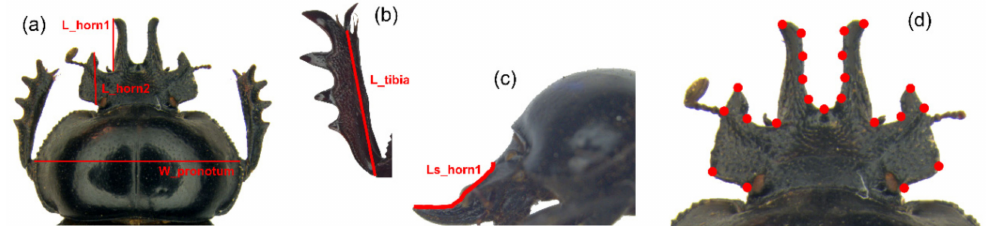
Figure 2. Linear measurements and landmark configuration. ( a ) Maximum pronotal width (W_pronotum), medialandlateralclypealhornlengths, dorsalview(L_horn1andL_horn2, respectively). ( b ) Fore tibia length, ventral view (L_tibia). ( c ) Medial clypeal horn length, side view (Ls_horn1). ( d ) Landmark configuration (N L = 23) for the